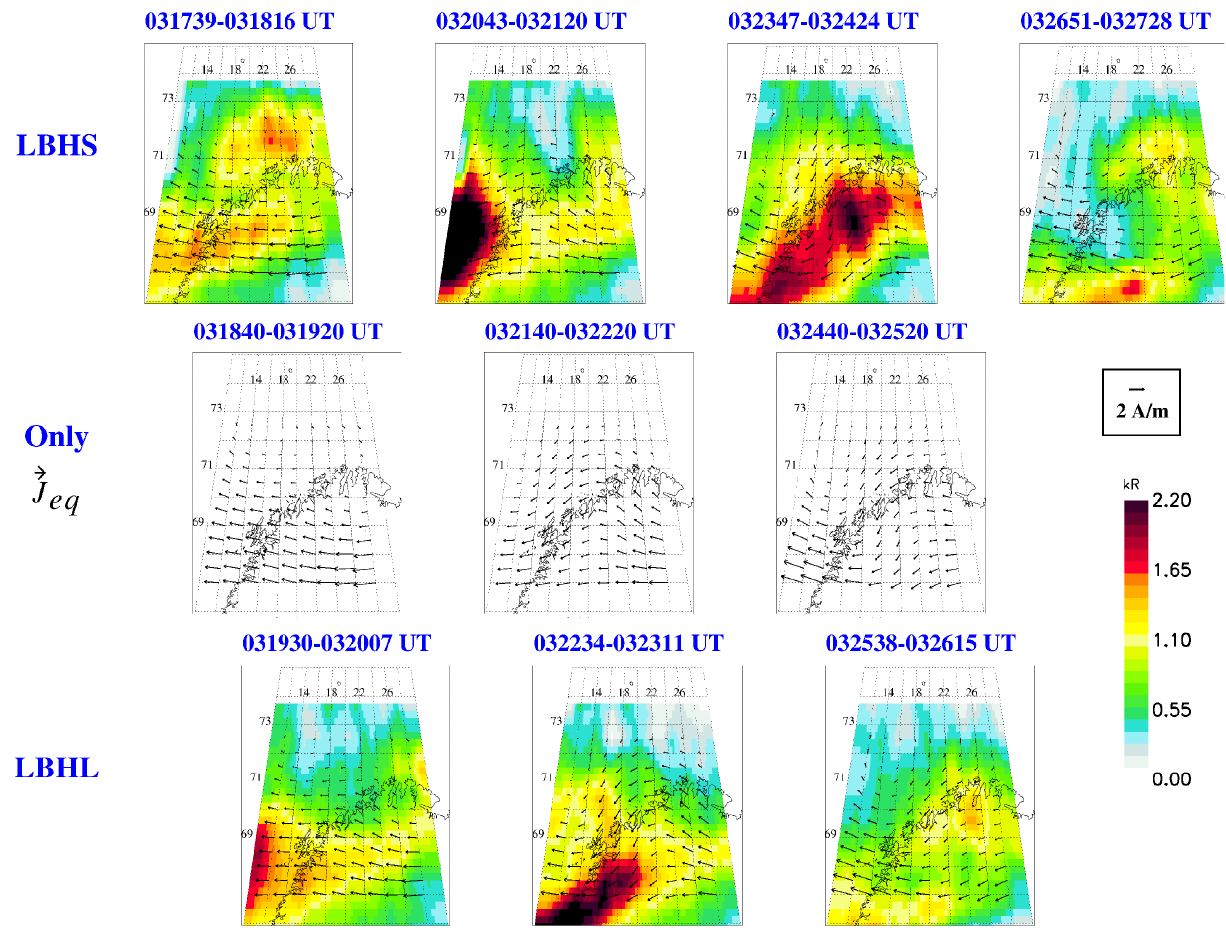
Fig. 3. Ionospheric equivalent currents (vectors) and UVI emissions (colour plots) for our detailed analysis interval. Plots around full minutes are organised from left to right with proceeding time, and according to the available UVI image: LBHS filter: upper row; LBHL filter: lower row; no UVI images: central row. The equivalent currents are averaged with respect to the UVI integration periods noted above each